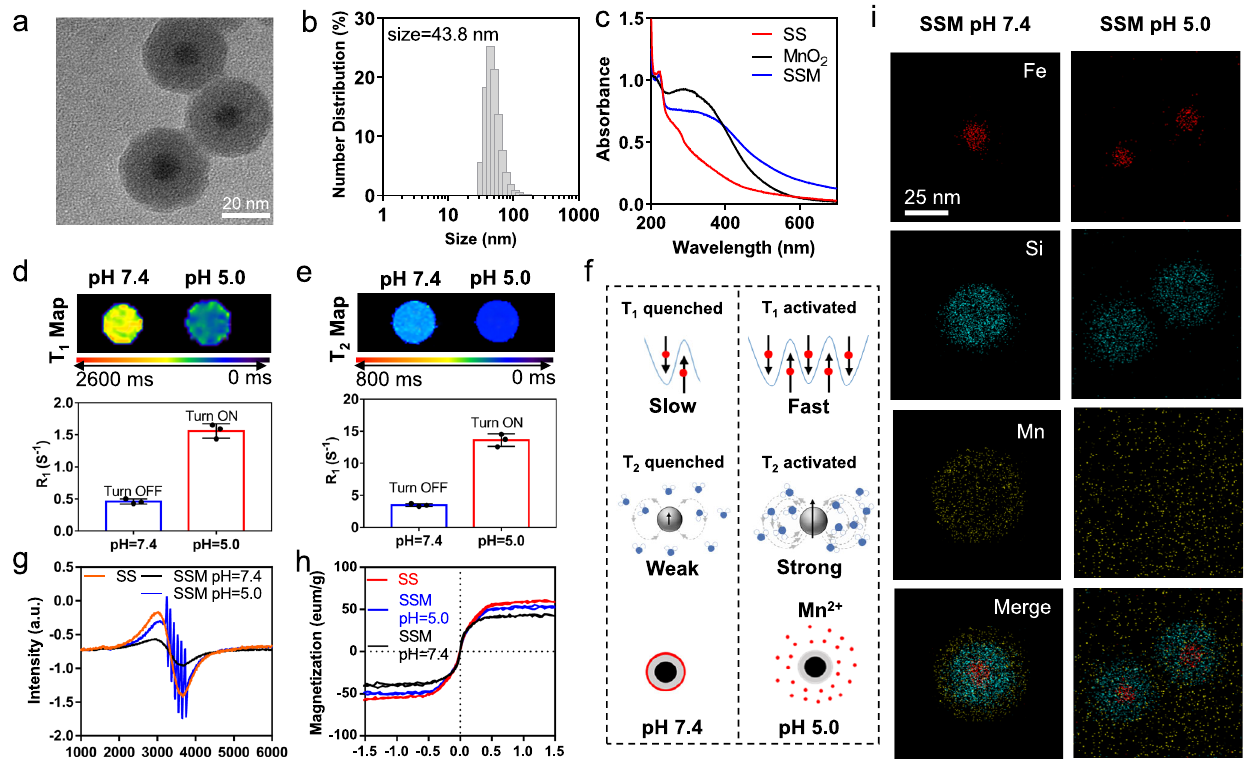
Fig. 2 | Characterization of SSM (SPIO@SiO 2 @MnO 2 ) and the pH-activatable properties.a TEM micrographand b sizedistribution of SSM. Representative data are shown from three independently repeated experiments. c Absorption spectra ofSS(SPIO@SiO 2 ),MnO 2 ,andSSM. d T 1 Map&R 1 ,and e T 2 Map&R 2 ofSSM,atpH 7.4 and 5.0 respectively. T 1 and T 2 Map are representative data from three inde- pendent samples. R 1 and R 2 data are presented as mean±SD from three